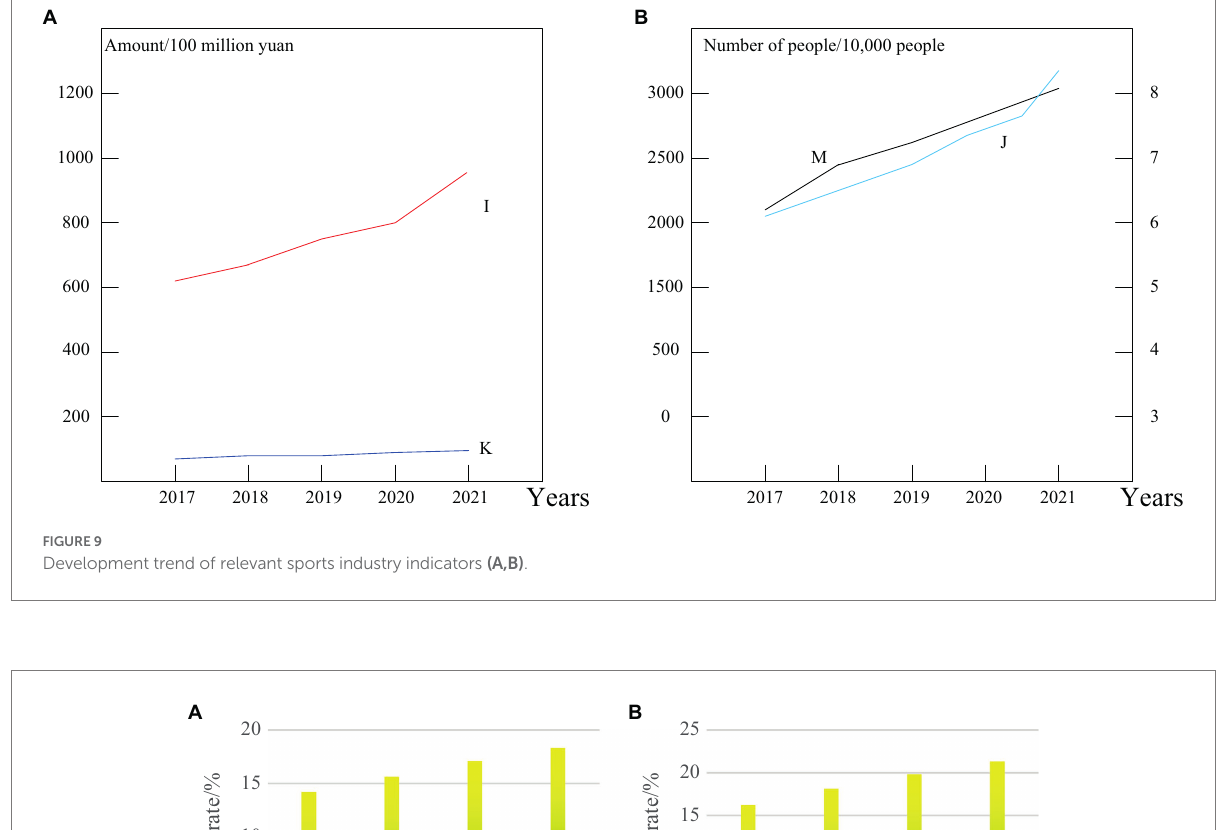
FIGURE 9 Development trend of relevant sports industry indicators (A,B) .